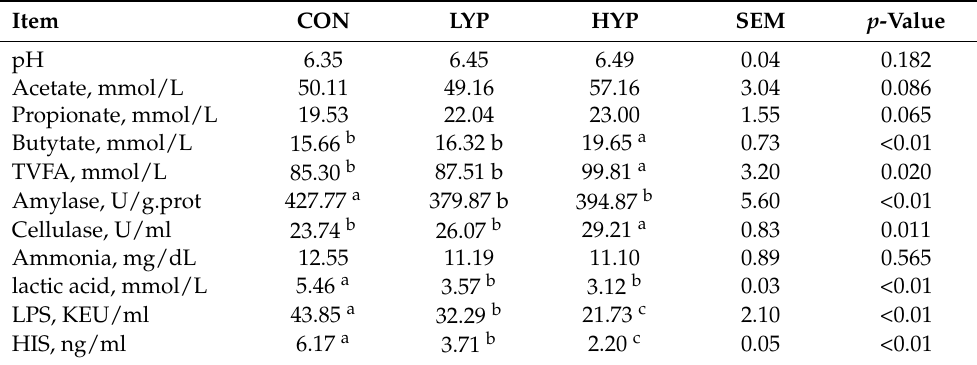
Table 1. Effects of yeast product on fermentation parameters, abnormal metabolites and digestive enzyme